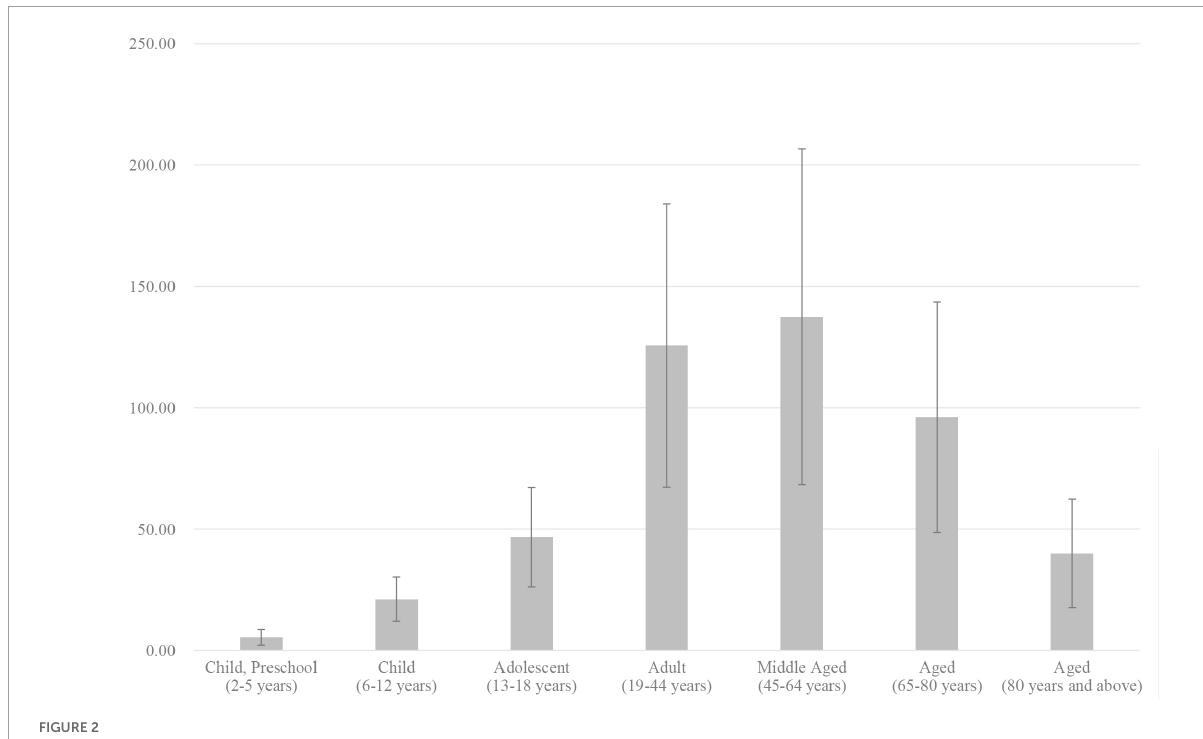
FIGURE1 PubMed search results: articles per year.